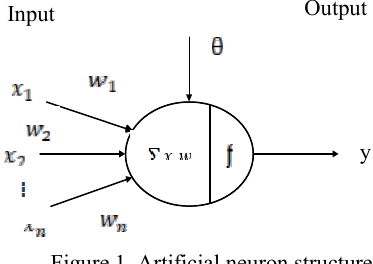
Figure 1. Artificial neuron